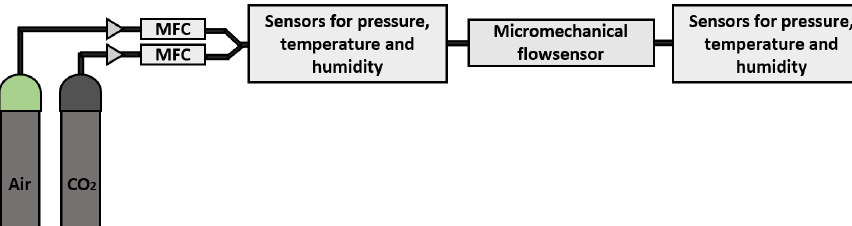
Figure 3. Principle representation of the measurement set-up for the analysis of an air–carbon-dioxide gas mixture with sensors for the detection of the cross-sensitivities and the micromechanical flow sensor (cantilever).